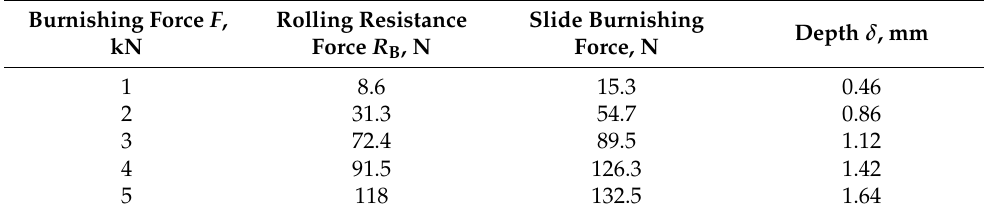
Table 5. The results of the depth of the plastically deformed layer δ for the various burnishing forces (burnishing with braking